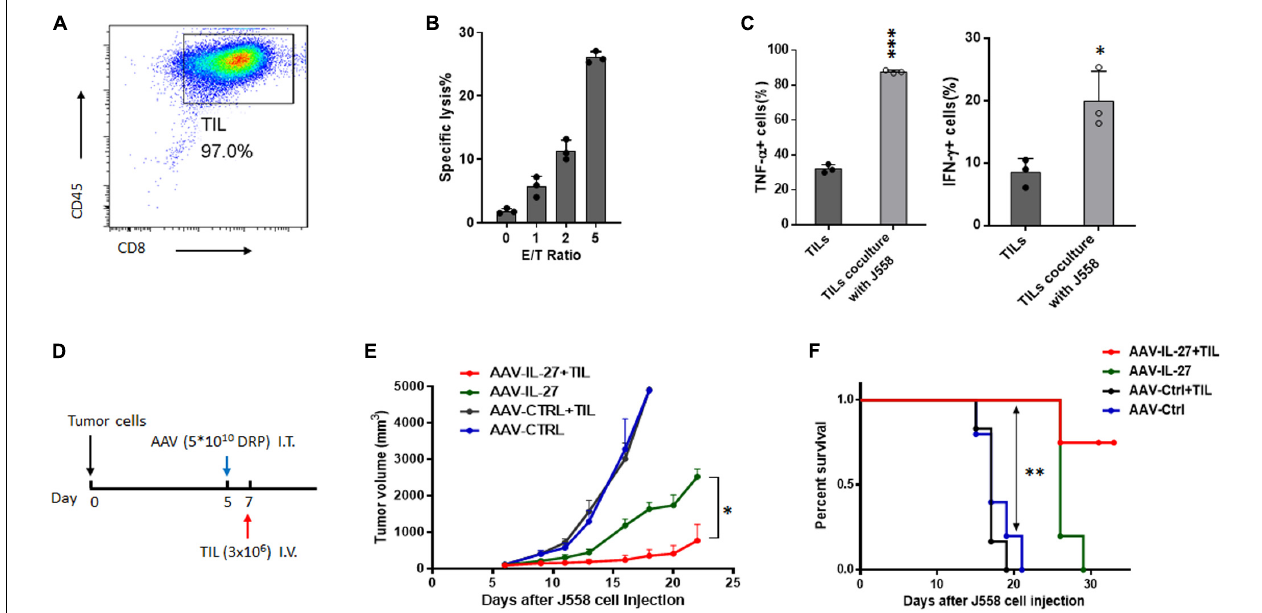
FIGURE 6 | Intra-tumoral injection of AAV–IL-27 enhances tumor-infiltrating T lymphocyte therapy. (A) Flow cytometry analysis of tumor-infiltrating lymphomcyte (TILs) isolated and expanded from J558 tumors grown in BALB/C mice. (B) TIL effector functions were quantify by flow cytometry-based cytotoxicity assay. (C) TILs from J558 tumors produced IFN- γ and TNF- α upon co-culture with J558 tumor cells in vitro . (D) Schematic diagram of intra-tumoral AAV-IL-27 and adoptive transfer of TILs. Mice were injected with J558 tumor cells s.c. Five days later, tumor-bearing mice were treated with AAV–IL-27 or AAV-ctrl virus intra-tumorally followed by injection of TIL T cells i.v. (E,F) Tumor growth (E) and survival of mice (F) bearing J558 tumors treated with intra-tumoral AAV-IL-27 and TILs. Data shown represent three independent experiments with n = 5 mice per group. * P < 0.05, ** P < 0.01 by One-way ANOVA or Log-rank